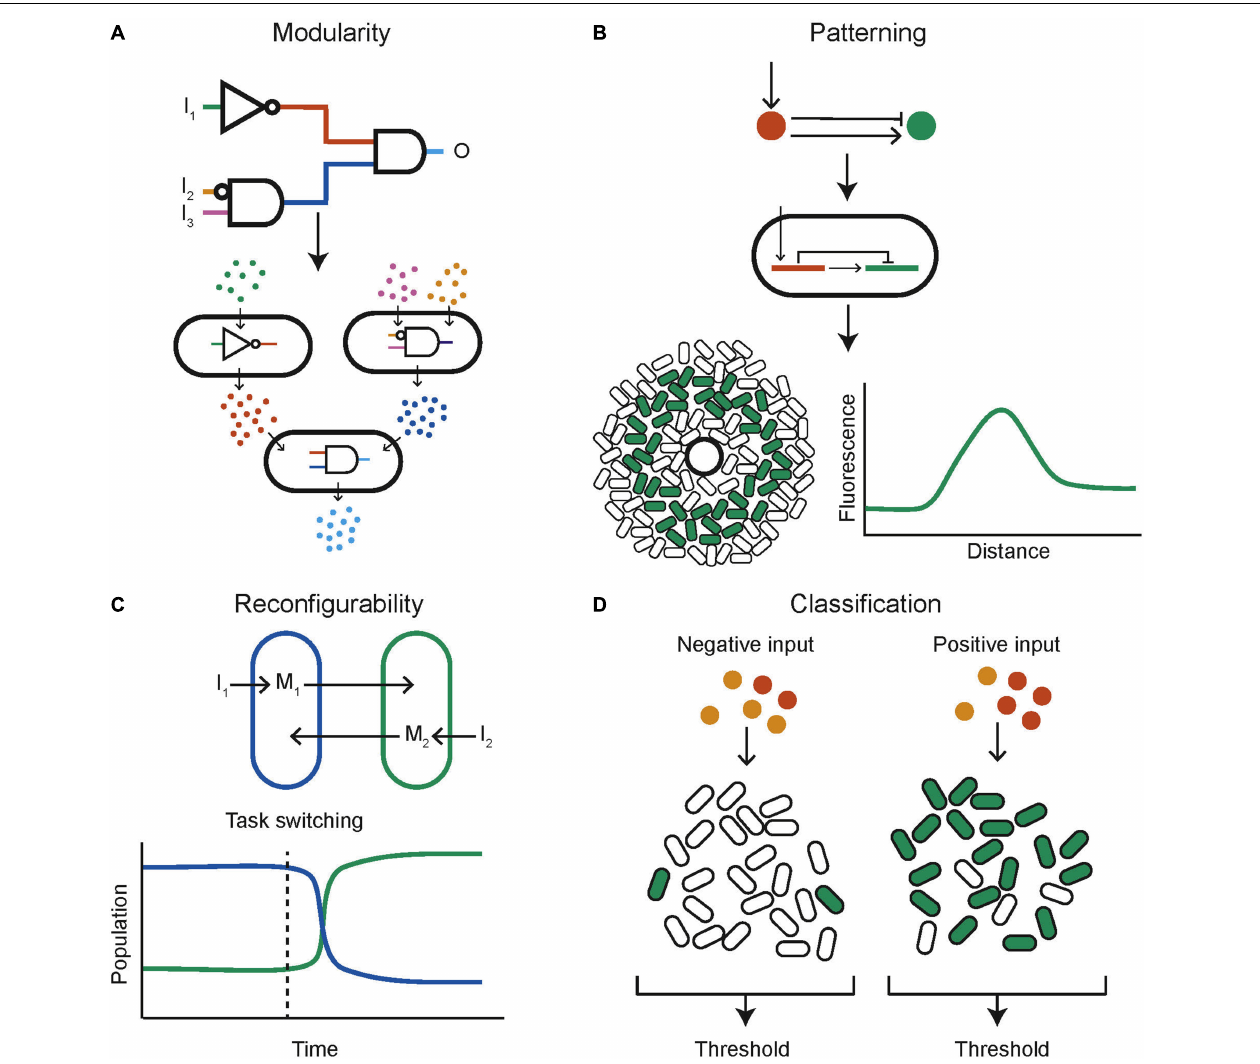
FIGURE 4 | Example capabilities of computational communities. (A) A complex circuit can be split into modules, distributed across different populations of cells (adapted from Regot et al., 2011). (B) Computational methods can be used to find networks capable of stripe formation, these can be programmed into cells using genetic circuits, the expressed phenotype of each cell depends on its position relative to a source of signaling molecule (adapted from Schaerli et al., 2014). (C) Reconfigurability could be a key capability of biological computing. Here the composition of a bacterial community can be controlled through inducers I1 and I2. This capability could be used to task switch in a computational bacterial community (adapted from Kerner et al., 2012). (D) Bacterial communities are naturally applicable to complex functions such as ensemble classification (adapted from Kanakov et al.,